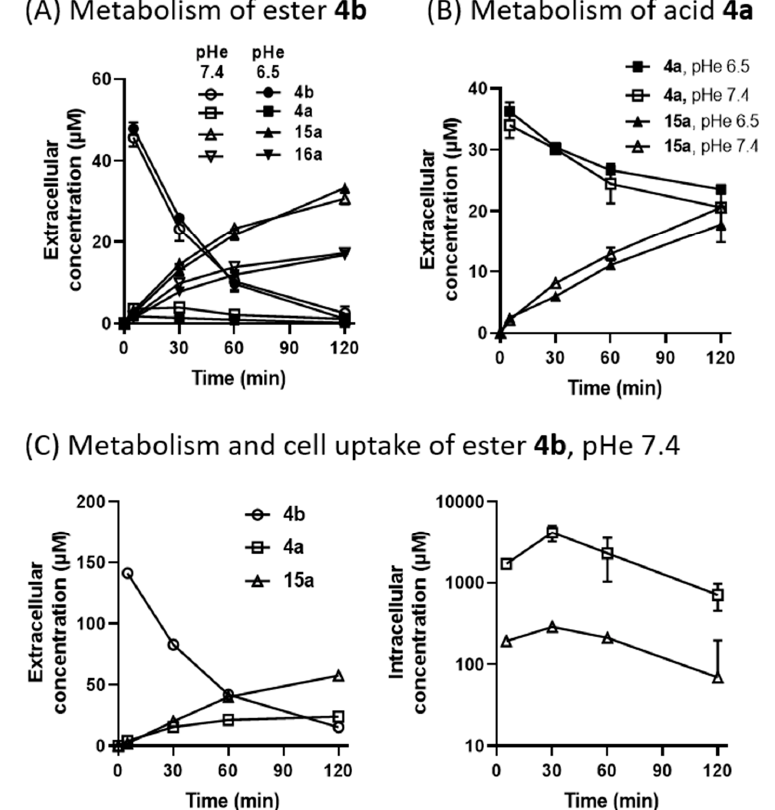
Figure 7. Metabolism of BTO ester 4b and the corresponding acid 4a by anoxic SiHa single cell suspensions (2 × 10 6 cells / mL). ( A ) Extracellular concentrations following the addition of 4b (50 µ M). suspensions (2 × 10 6 cells/mL). ( A ) Extracellular concentrations following the addition of 4b (50 μ M). ( B ) Extracellular concentrations following the addition of 4a (50 µ M). ( C ) Extracellular (left) and ( B ) Extracellular concentrations following the addition of 4a (50 μ M). ( C ) Extracellular (left) and intracellular (right) concentrations following the addition of 4b (150 µ M). Values are means and errors intracellular (right) concentrations following the addition of 4b (150 μ M). Values are means and errors are SEM for 3 replicate are SEM for 3 replicate cultures.